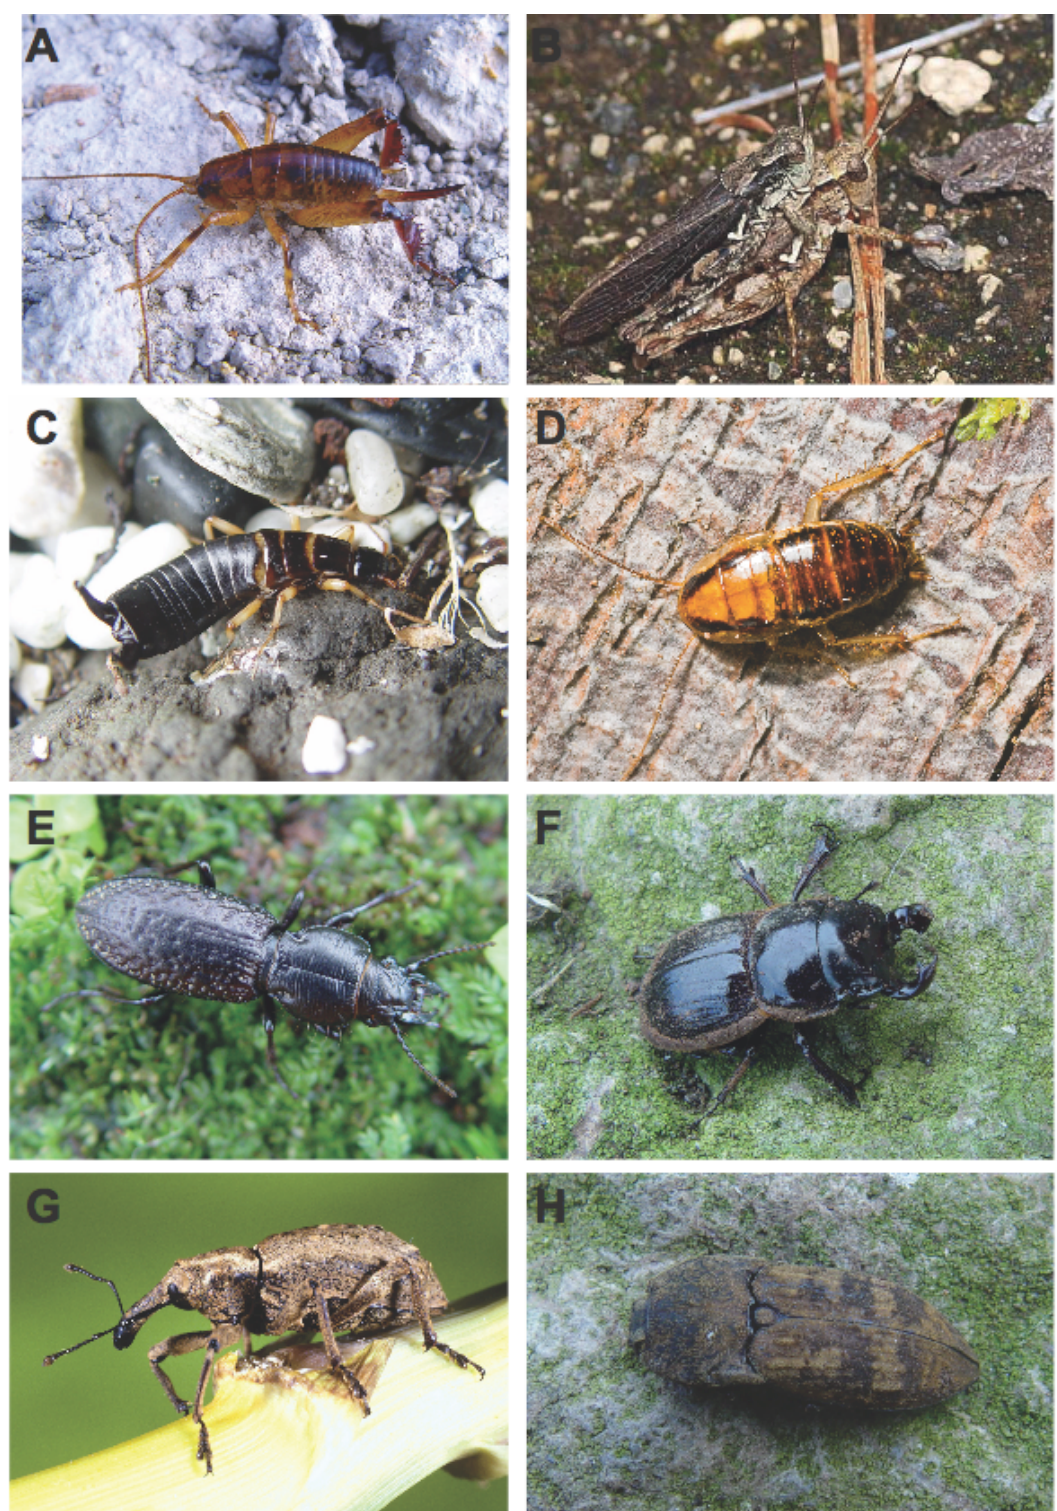
Figure 2. ( A) Talitropsis megatibia ; (B) Phaulacridium marginale with rare winged male;